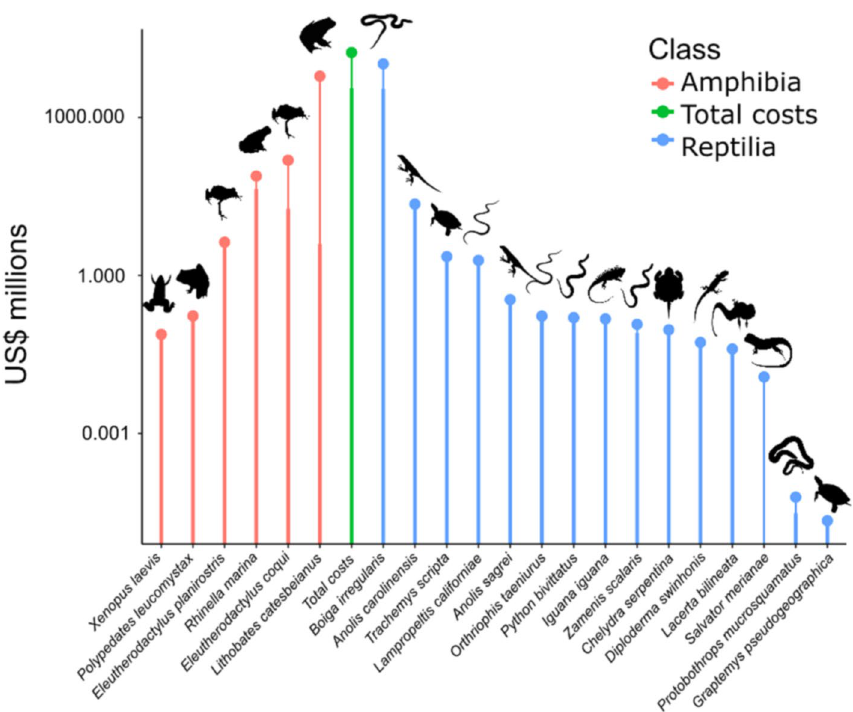
Figure 2. Cost per species for both classes. Red bars represent amphibians, while blue bars represent reptiles. The green bar represents the total cost of invasive herpetofauna. The wide, lower part of the bar represents the observed costs, while the thinner part represents the total costs ( Observed plus Potential costs). Note that the y -axis is on a log 10 scale. Animal silhouettes are from PhyloPic